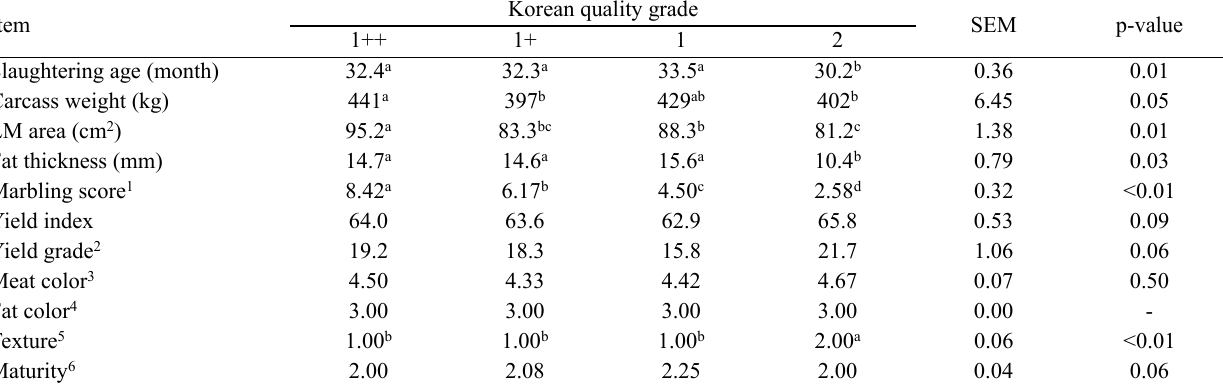
Table 3. Means and standard errors of slaughter age and carcass characteristics of Korean cattle steers with different quality grades examined by an official meat grader Item